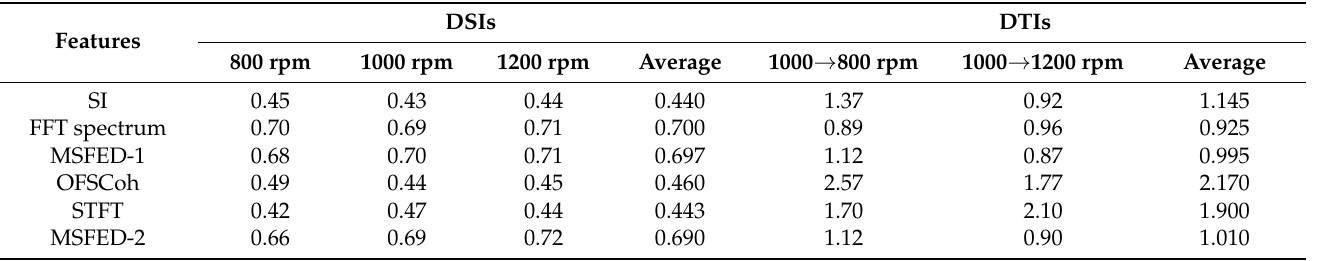
Table 6. The DSIs of six initial features on the gearbox dataset and the bearing